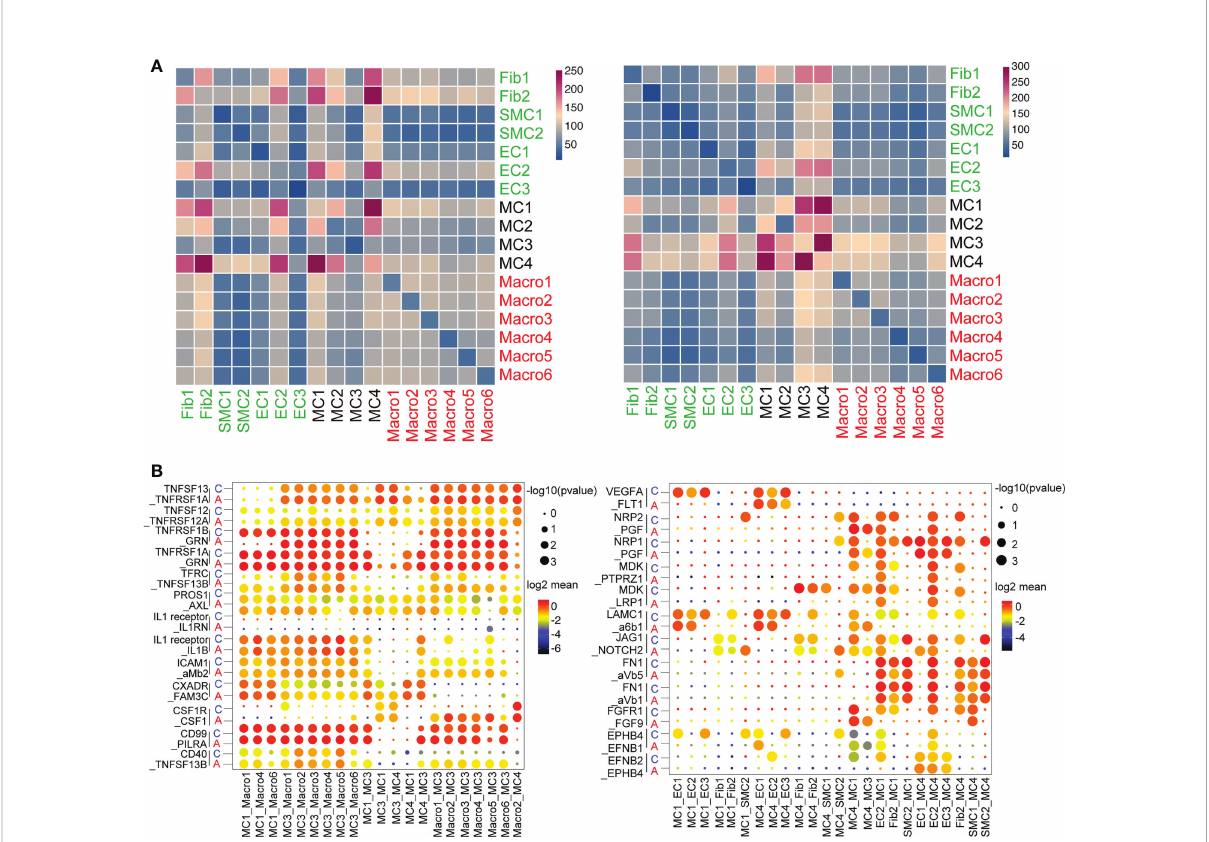
FIGURE 7 Unique cell-to-cell signaling networks may contribute to the development of asthma in cynomolgus monkeys. (A) , Heatmap depicting the number of all possible interactions between all the stromal, mesenchymal and macrophage clusters. Cell types were grouped by broad lineage. (B) , Dot plot depicting selected stromal – stromal and stromal – mesenchymal interactions enriched in healthy airways but absent in asthmatic airways (left). Dot plot showing selected mesenchymal – immune interactions highly enriched in the asthmatic airways but absent in the healthy airways